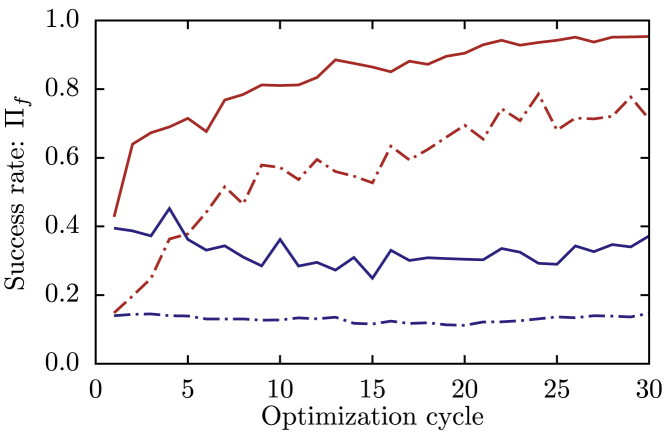
Average success rates of the folding trajectories performed during the optimization procedure. The reported quantity, Πf, is a proxy of the folding probability, the definition of which is provided in the Methods. The red curves correspond to MFFO combining NK = 16 force-fields, and the blue curves correspond to an MFFO without crossover of force-fields, equivalent to NK parallel SFFOs. Solid lines indicate the success rate of the best-ranked force field, and dot-dashed line indicates the average rate of the NK concurrent force fields. To see this figure in color, go online.